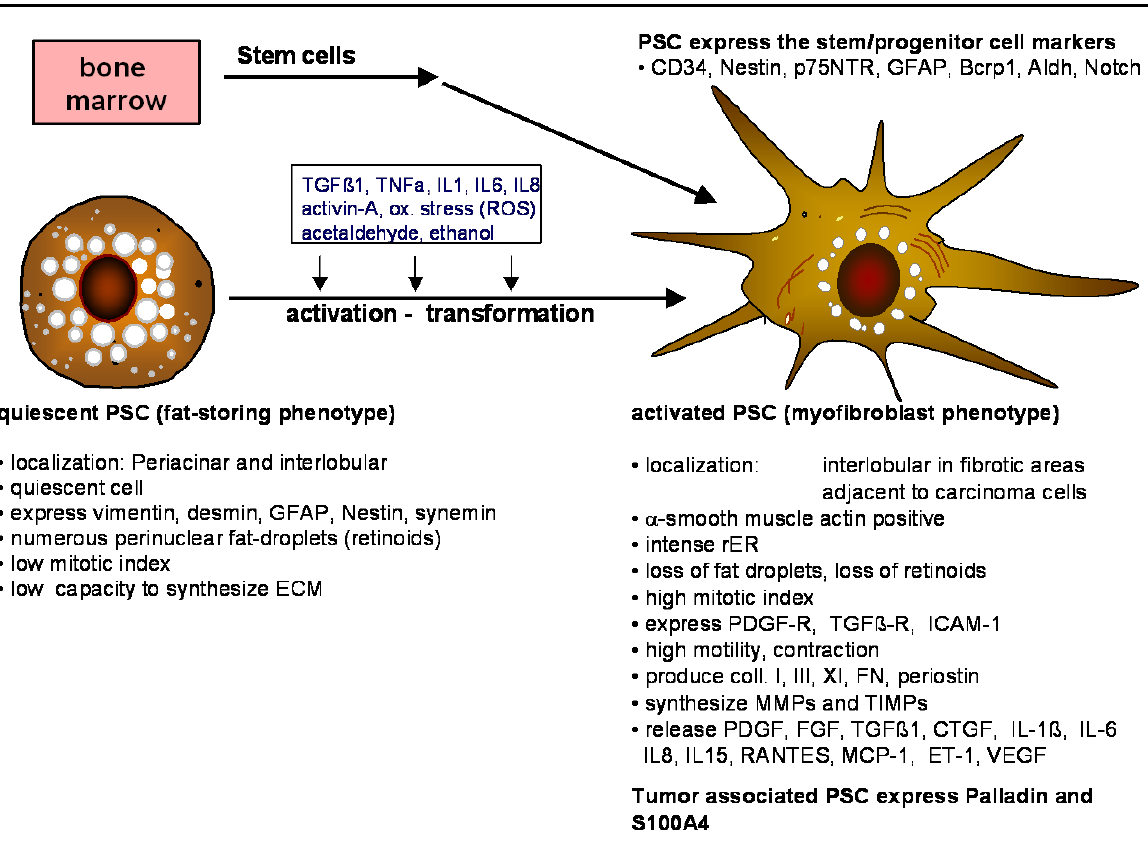
Figure 1. Characteristics of quiescent (fat-storing phenotype) and activated PSC (myofibroblast-like phenotype). In acute and chronic pancreatitis, but also in pancreas carcinomas, PSC change their phenotype from a quiescent fat-storing phenotype to a highly active myofibroblast-like phenotype. Hereby the cells lose their Vitamin A containing fat droplets, express other cytofilaments, increase their proliferation rate and produce growth factors, cytokines, connective tissue, MMPs and TIMPs. In addition, as we have learned recently from animal models, part of the activated PSC originate from stem/progenitor cells of bone